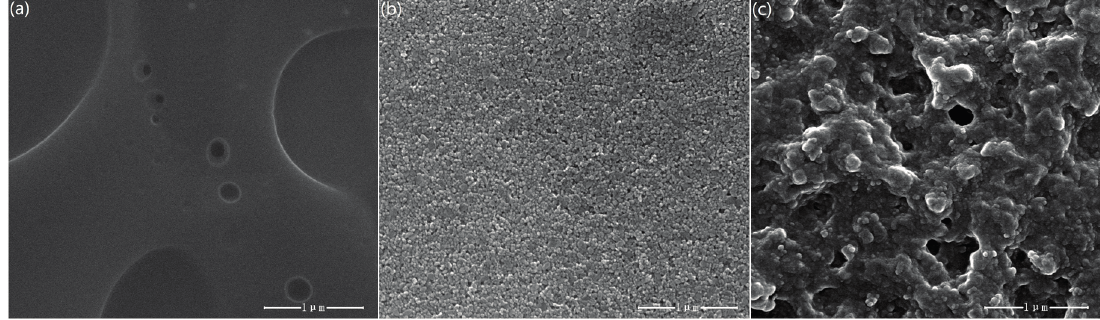
Figure 3. SEM graphs of sprayed ( a ) P3HT film; ( b ) ZnO film; ( c ) P3HT-ZnO hybrid film.